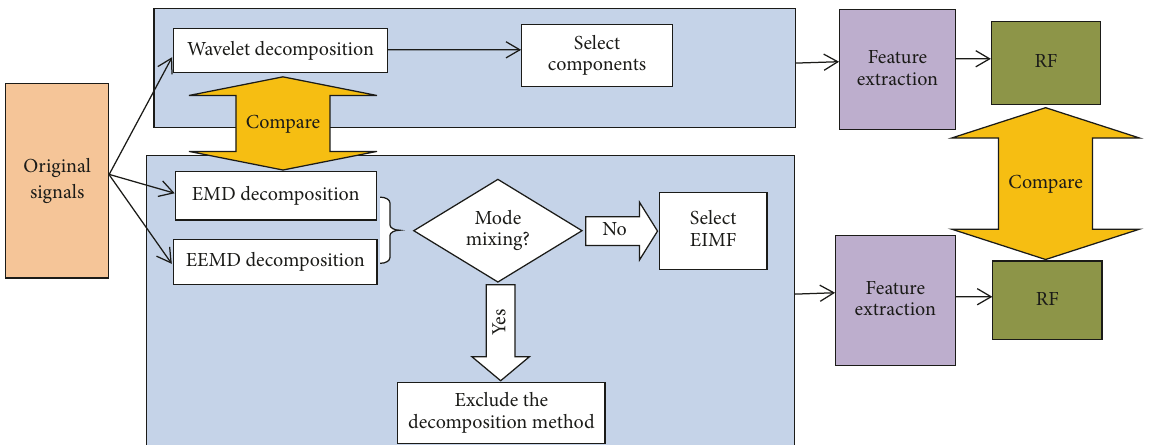
Figure 2: Fault diagnosis based on EEMD and RF and comparison with wavelet.